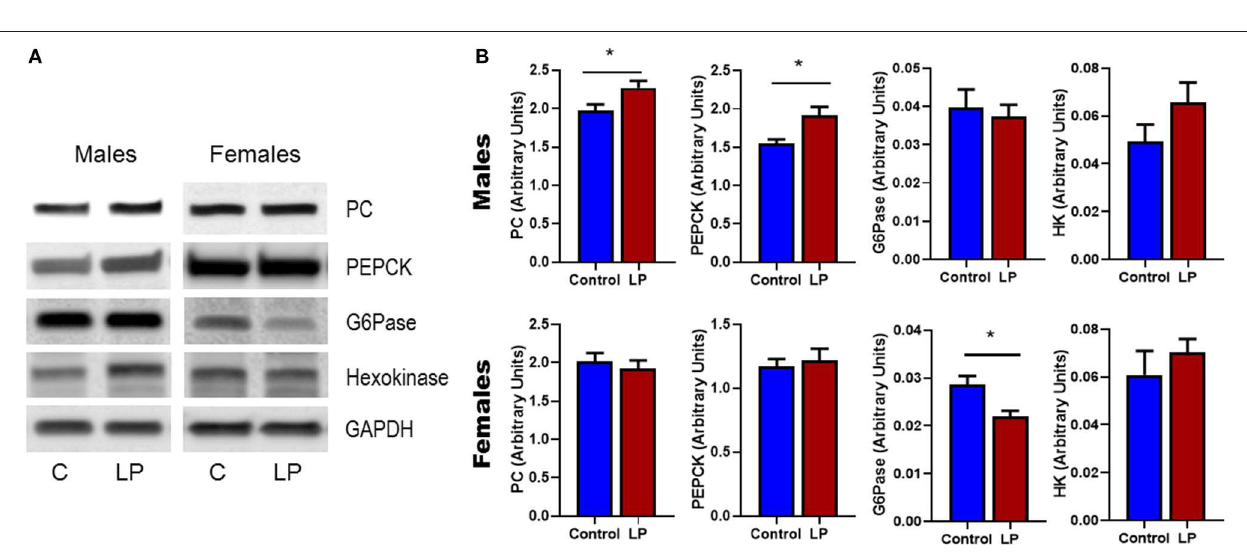
rate of glucose production did not show any difference between fasting and simulated fed condition (4.6 ± 0.3 mg ∗ kg − 1 ∗ min −